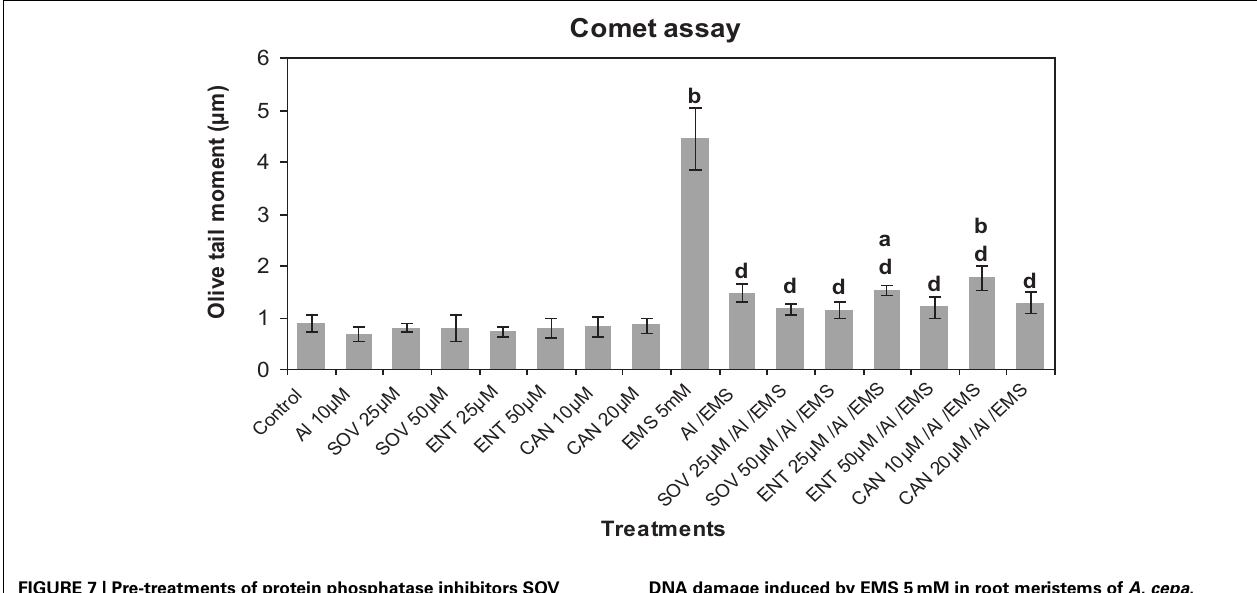
FIGURE 7 | Pre-treatments of protein phosphatase inhibitors SOV (Na 2 VO 4 ) 25 and 50 µ M; ENT (endothall) 25 and 50 µ M; CAN (cantharidin) 10 and 20 µ M prevented Al-induced adaptive response to